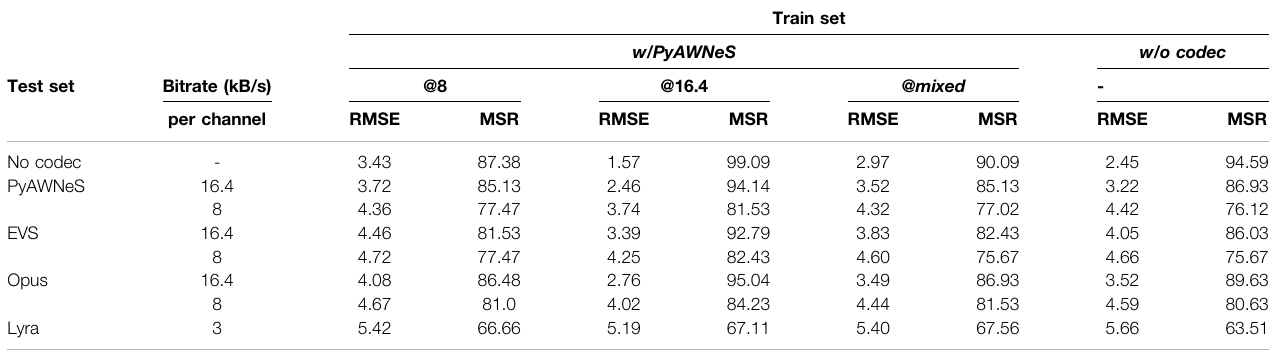
TABLE 2| Performance interms ofRMSE( ◦ )and MSR% inseenand unseen codecs conditionsusing the modelservingasbaseline trained withoutcodec ( w / ocodec ) and models trained with PyAWNeS at 16.4, 8 kB/s and mixed bitrate repectively named as ( w / PyAWNeS@ 16.4), ( w / PyAWNeS@ 8), ( w / PyAWNeS@mixed ). Train set w / PyAWNeS w / o codec